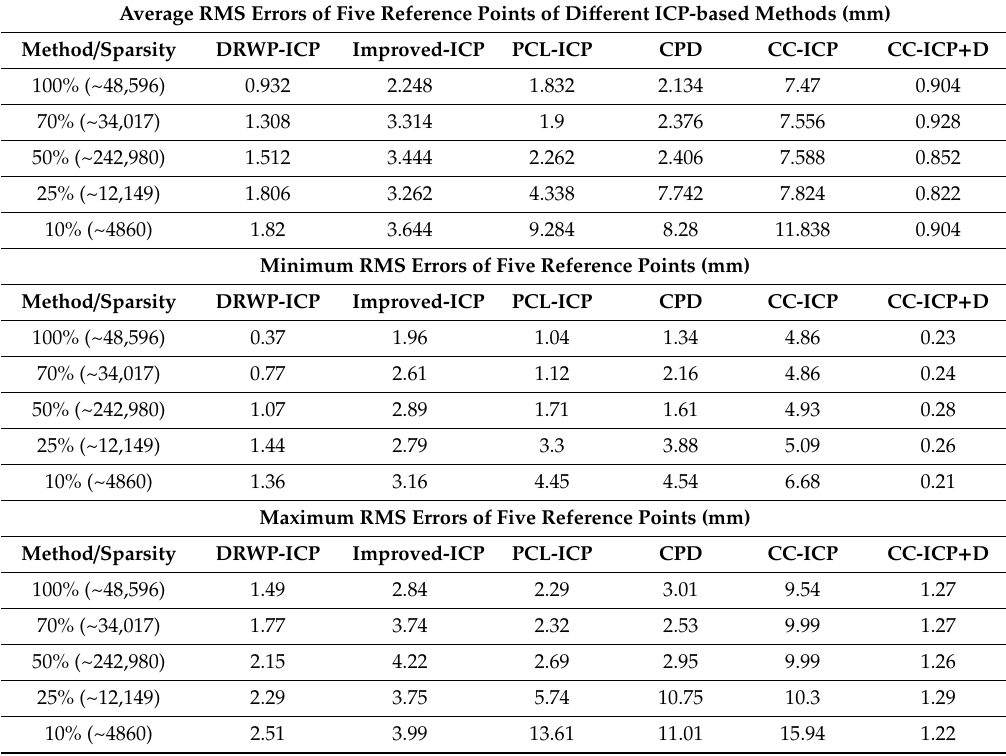
Table 8. The Average, Minimum and Maximum of Reference Points’ Alignment